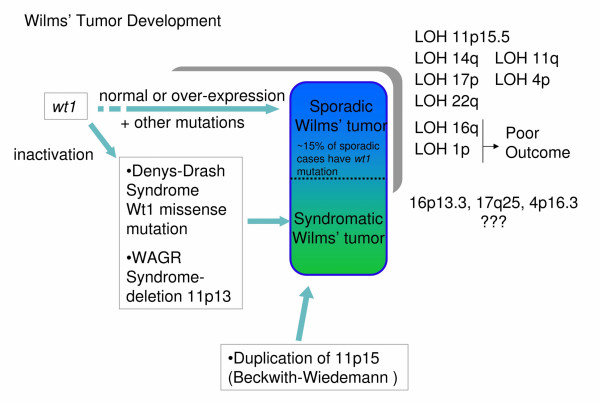
Pathways to Wilms' Tumor. Genetic changes leading to Wilms' Tumor. Cancer occurs through the sporadic or the syndromatic pathway. Loss of heterozygosity (LOH) and loss of imprinting (LOI) are generally associated with sporadic pathways, but are occasionally found in syndromatic tumors. The gray bar indicates that the LOH may occur anywhere along the development of the sporadic cancer. Most sporadic cases (but not all) have a wild-type overexpressed WT1 gene. It is possible that LOH, LOI, and other genetic changes in sporadic tumors compensate for the presence or over-expression of WT1. LOH at regions 16q and 1p correlate with poor prognosis. Other regions often showing LOH are listed. Regions 16p13.3, 17q25, and 4p16.3 are statistically enriched for predicted targets of WT1 but their involvement in tumor formation is unknown.